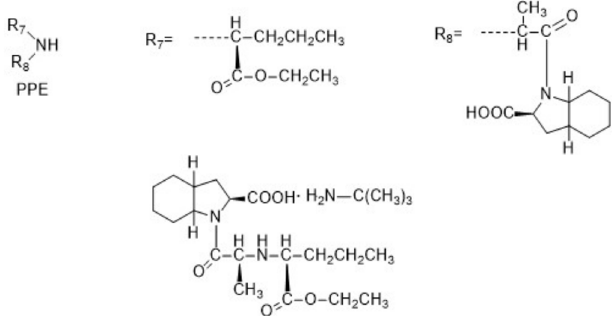
FIGURE 1 - Structure of perindopril erbumine